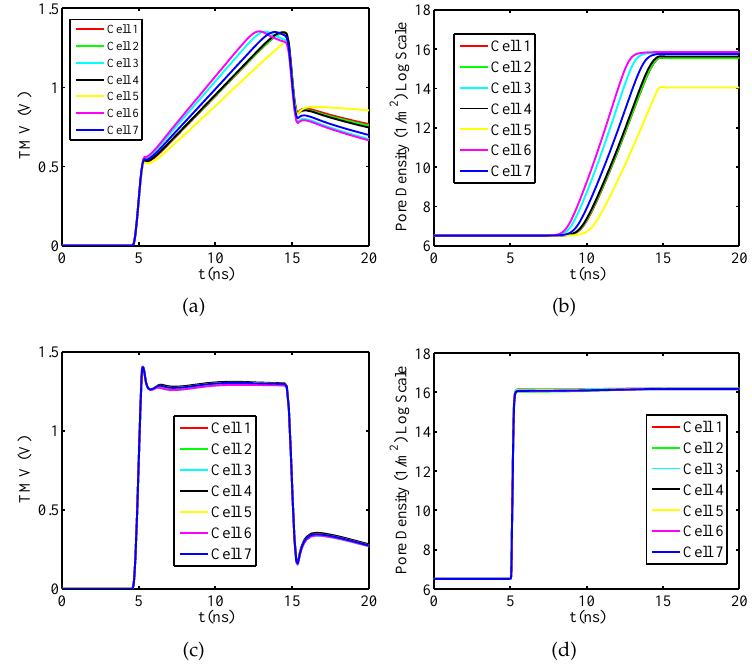
Figure 8. Sparse System—Temporal evolution of ( a ) TMV and ( b ) pore density for plasma membranes at the angular placement θ = 75 ◦ . Temporal evolution of ( c ) TMV and ( d ) pore density for nuclear membranes at the angular placement θ = 75 ◦ . Pulse amplitude and duration equal to 100 kV/cm and 10 ns,